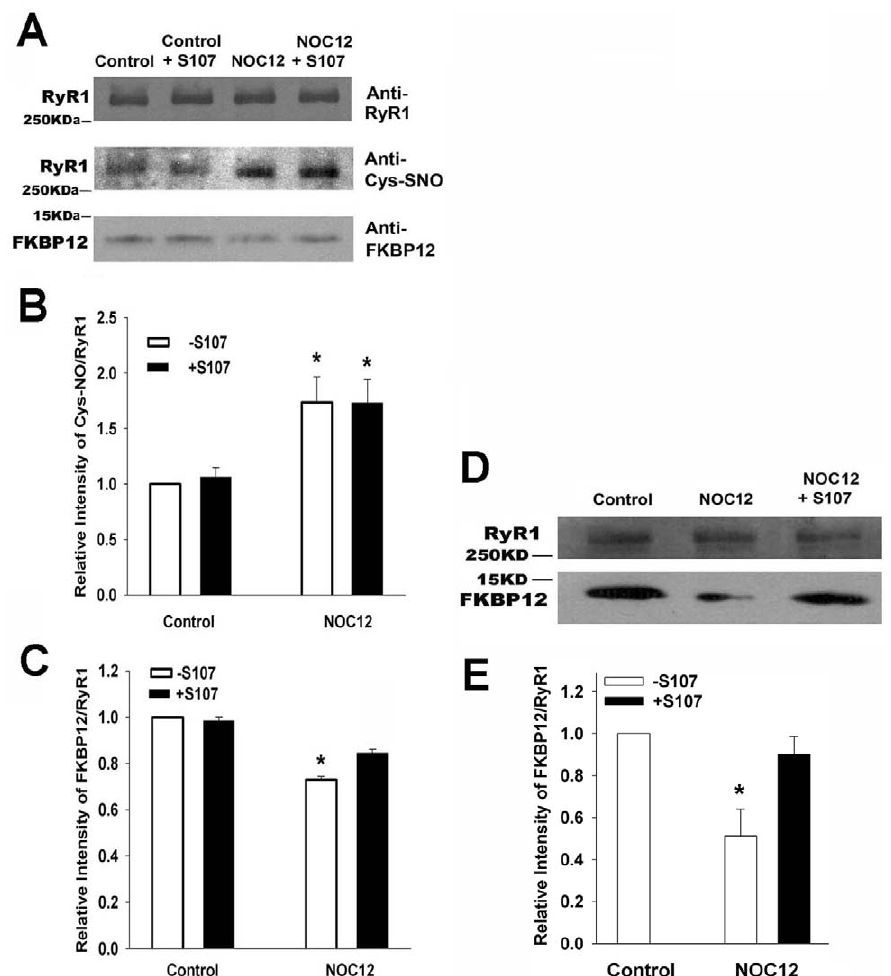
Figure 3. FKBP12 dissociation from SR vesicles in the presence of NOC12. (A–C) SR vesicles not treated with FK506 were incubated for 5 h at 24 u C with or without 0.10 mM NOC12 in the absence and presence of 44 m M S107 in 0.25 M KCl, 20 mM imidazole, pH 7.0, 7 m M free Ca 2 + and protease inhibitors. S-nitrosylation was stopped by centrifugation. Resuspended samples were separated on 8–20% (FKBP12) and 3–12% (RyR1 and Cys-SNO) gradient SDS-PAGE gels and transferred to nitrocellulose membranes to detect S-nitrosylation of RyR1, and FKBP12 and RyR1 proteins. Data are the mean 6 SEM of 4 determinations. *p , 0.05 compared to control samples (B) and samples with NOC12 and S107 (C). (D and E) SR membranes were incubated with and without 44 m M S107 and 0.1 mM NOC12 at 24 u C for 90 min, solubilized, and immunoprecipitated as described in Methods. Immunoblots of RyR1 and FKBP12 are shown. Data are the mean 6 SEM of 4 experiments. * p , 0.05 compared to control samples and samples incubated with NOC12 and